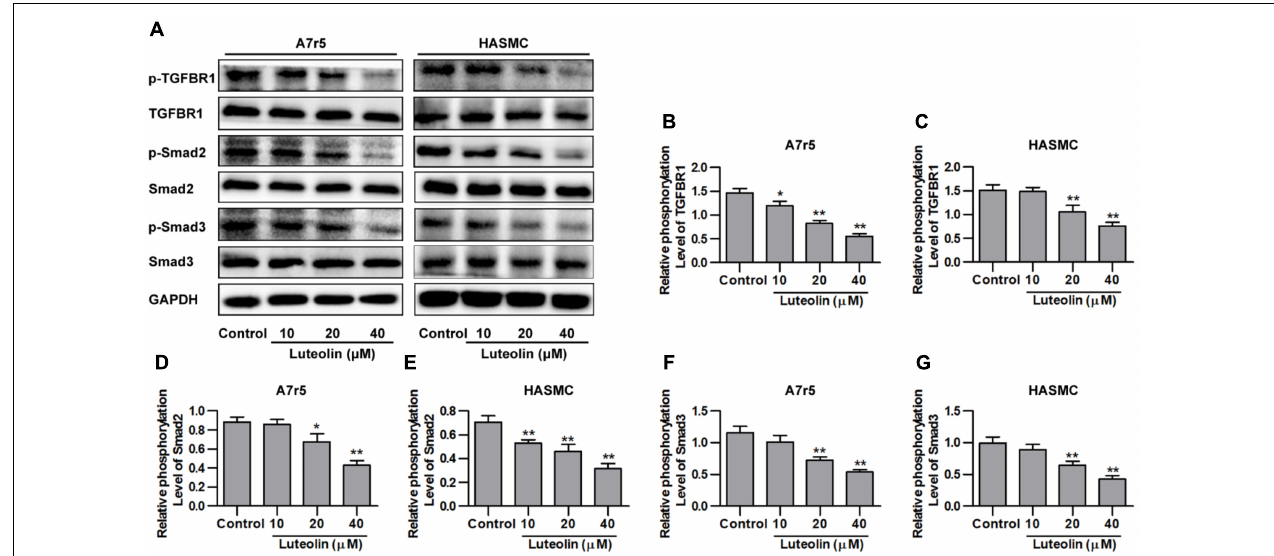
FIGURE 3 | Luteolin suppresses activation of the TGFBR1 signaling pathway. (A) A7r5 and HASMC cells, respectively, were incubated with luteolin (10, 20, and 40 µ M) for 1 h, and the expression levels of p-TGFBR1, TGFBR1, p-Smad2, Smad2, p-Smad3, and Smad3 were tested by western blotting. (B – G) Relative phosphorylation levels of TGFBR1, Smad2, and Smad3 ( n = 3). Data are presented as the mean ± SD. ∗ P < 0.05, ∗∗ P < 0.01, compared to the control group.